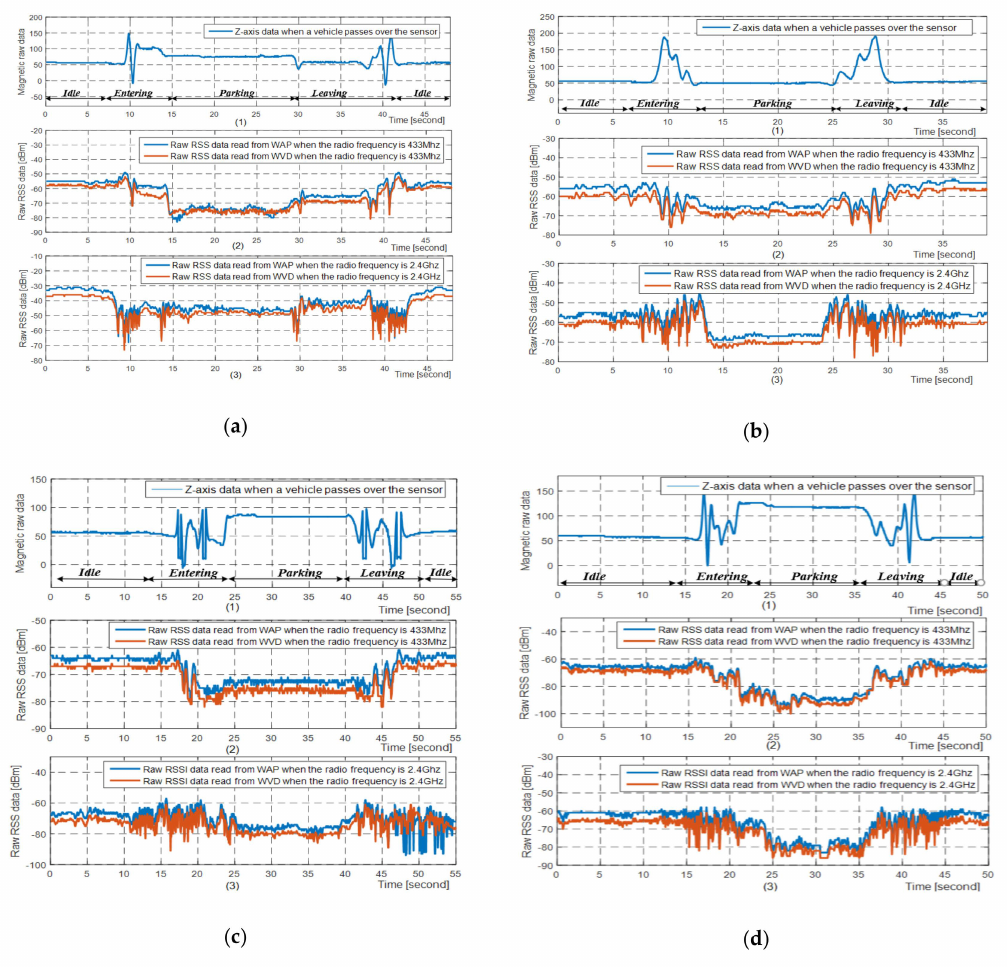
Figure 4. The raw magnetic raw data and raw RSSs a ff ected by vehicle parking processes, and the tested vehicle is an MPV Buick GL8. ( a ) The WAP antenna is 3-meter-high and there are no vehicles in the parking spaces between WAP and WVD as the scenario shown in Figure 3b1; ( b ) The WAP antenna is 3-meter-high and there are some vehicles in the parking spaces between WAP and WVD as the scenario shown in Figure 3b3; ( c ) The WAP antenna is 6-meter-high and there are some vehicles in the parking spaces between WAP and WVD as the scenario shown in Figure 3b3; ( d ) The WAP antenna is 10-meter-high and there are some vehicles in the parking spaces between WAP and WVD as the scenario shown in Figure